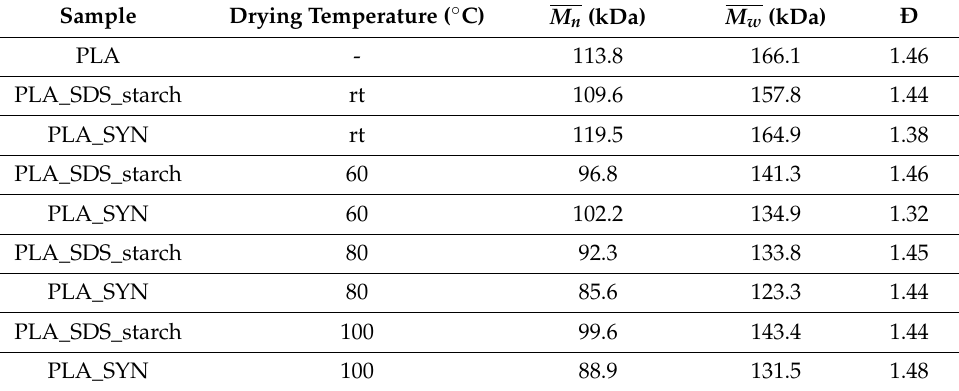
Table 4. Molecular weight by GPC analysis of pristine PLA and PLA dispersions dried at differ- ent